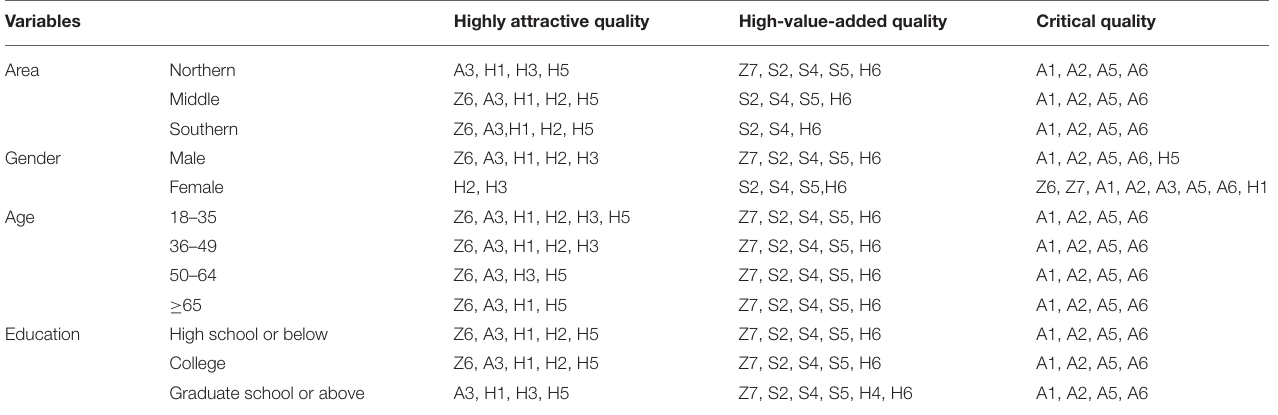
TABLE 6 | Relationship between different variables and preferences of design strategies. Variables Highly attractive